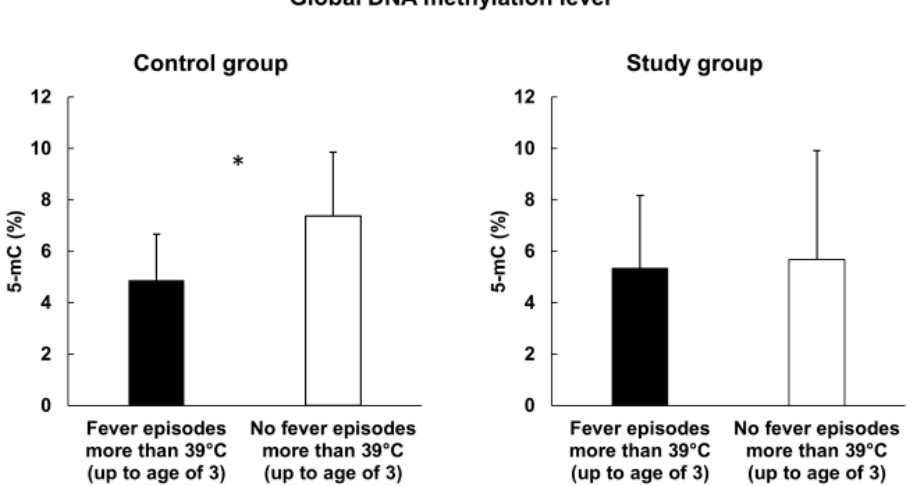
Figure 5. Global methylation level and fever episodes; *—statistically significant.